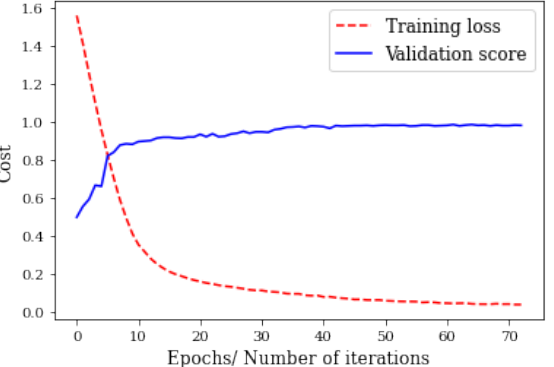
Figure 7. DNN training/validation process over 160